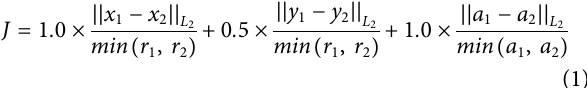
Frontiers in Bioengineering and Biotechnology |